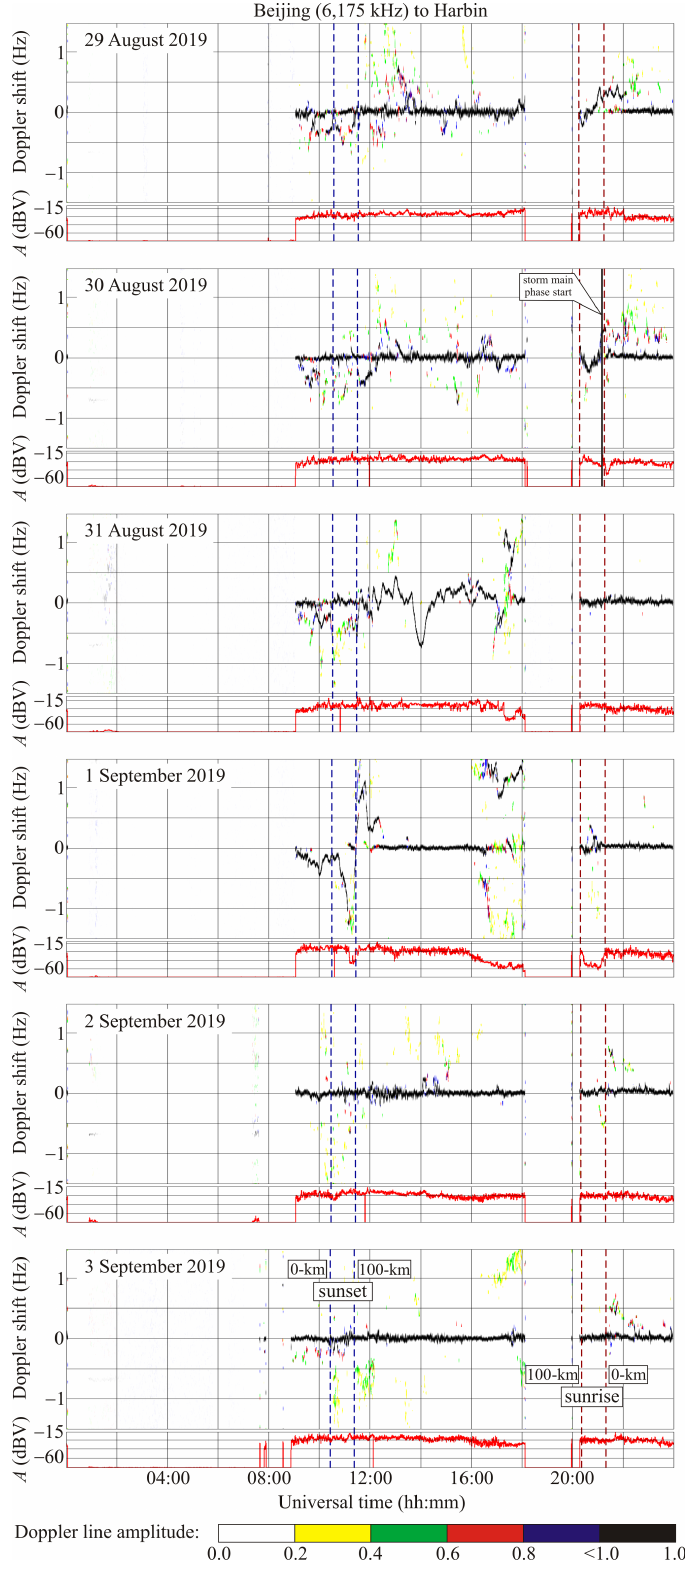
Figure 8. Same as Fig. 5 but for the Beijing to Harbin radio wave propagation path at